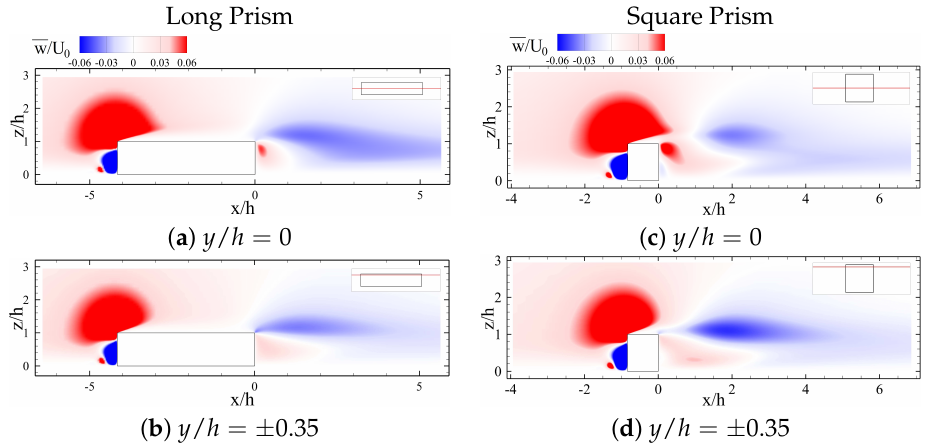
Figure 14. Contours of spanwise velocity at different planes along ( a , b ) the long prism and ( c , d ) the square prism. Red and blue regions correspond to upwash and downwash flow, respectively.